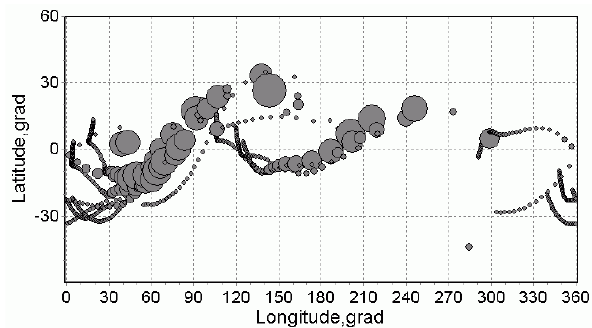
Fig. 3. Asymptotic directions for vertical incident particles for en- ergy < 15GeV registered by neutron monitors available in February 1956. The circle radii correspond to the contribution of particles at fixed energy for power spectra with index